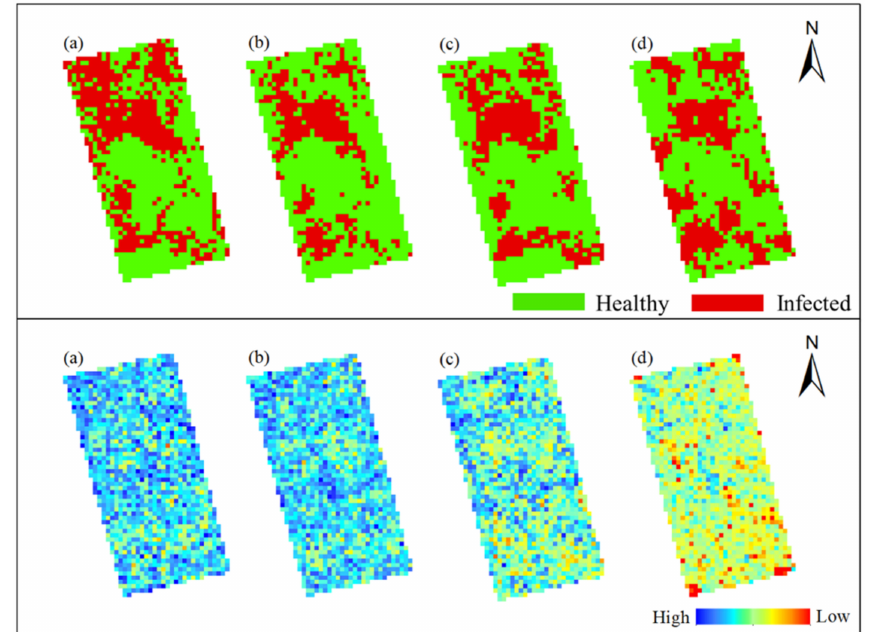
Figure 15. Spatiotemporal variation of occurrence area of rice false smut corresponding SPAD values in Plot 2: ( a ) 14 August 2020; ( b ) 20 August 2020; ( c ) 25 August 2020; ( d ) 6 September 2020.